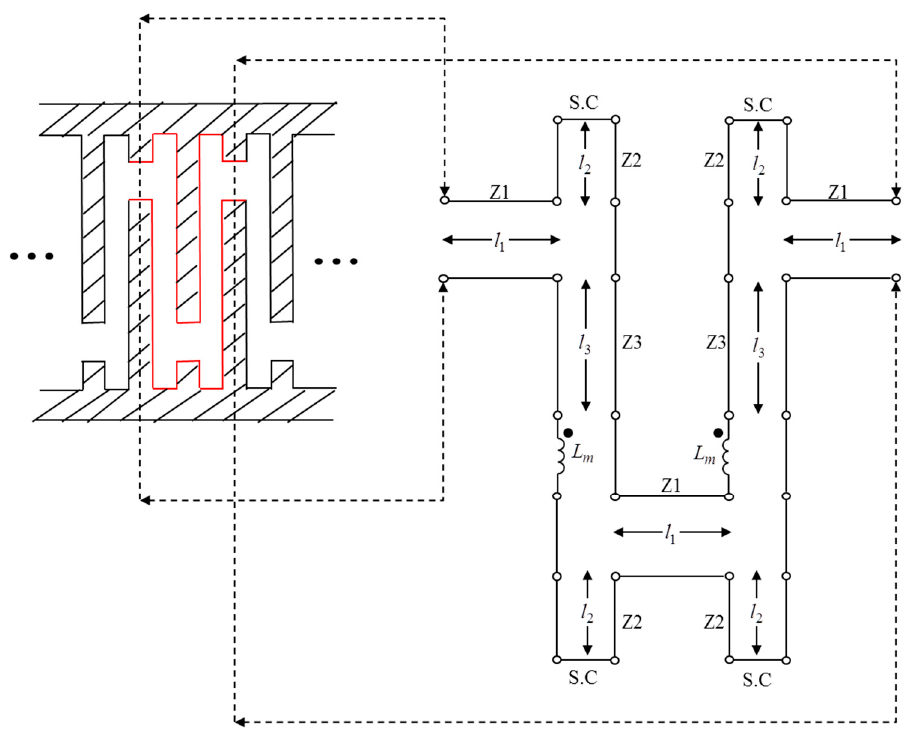
Figure 4. Transmission line equivalent circuit of the meander gap.